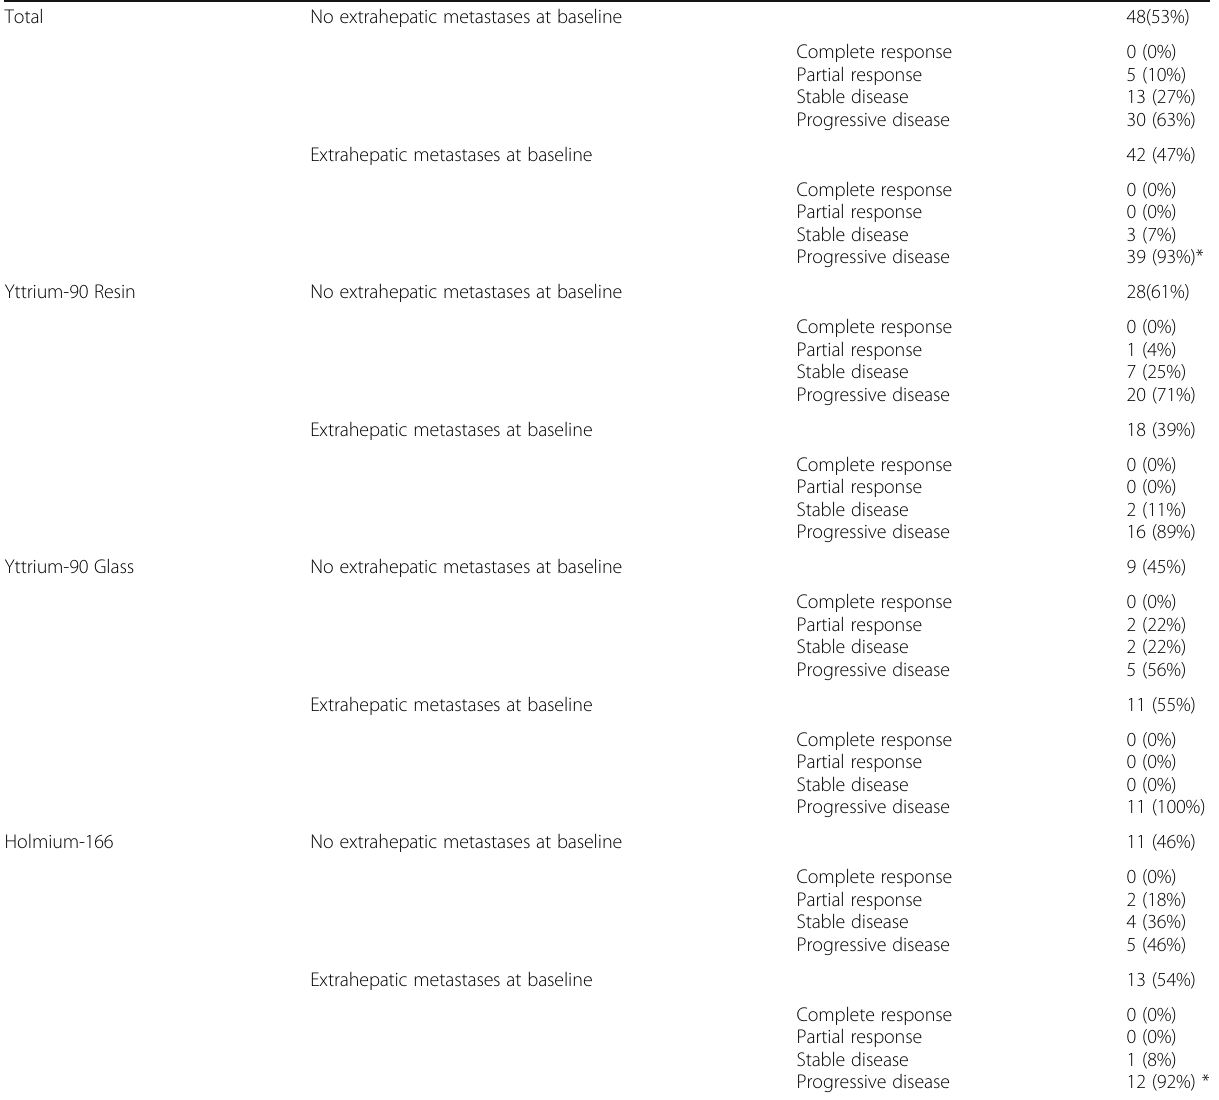
Table 3 RECIST 1.1 response classification at 3 months